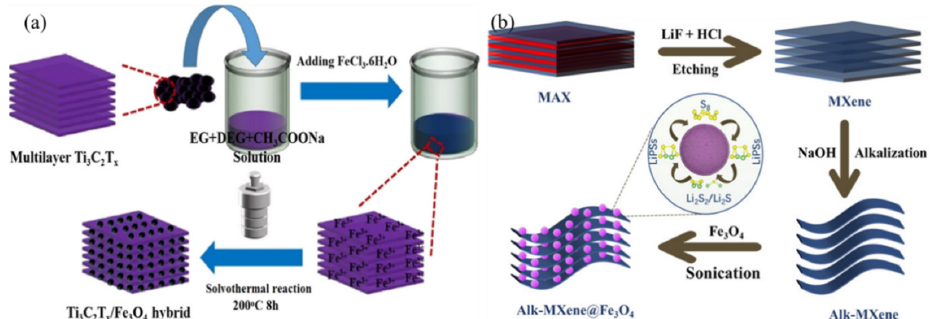
Figure 8. ( a ) Schematic synthesis process of Mxene/Fe 3 O 4 nanocomposite through Solvothermal process. Reproduced with permission from [81]. ( b ) Schematic synthesis process of Alk-MXene composites with Fe 3 O 4 through ultrasonic treatment. Reproduced with permission from [29] copyright (2022) John Wiley and Sons.